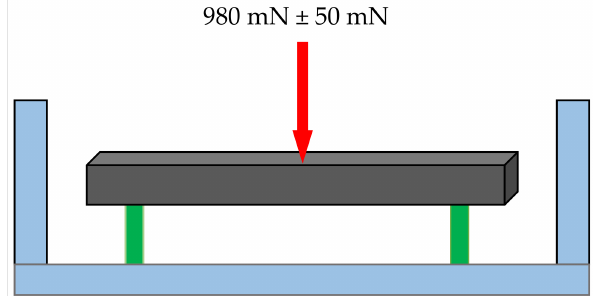
Figure 4. Schematic figure of the bending beam